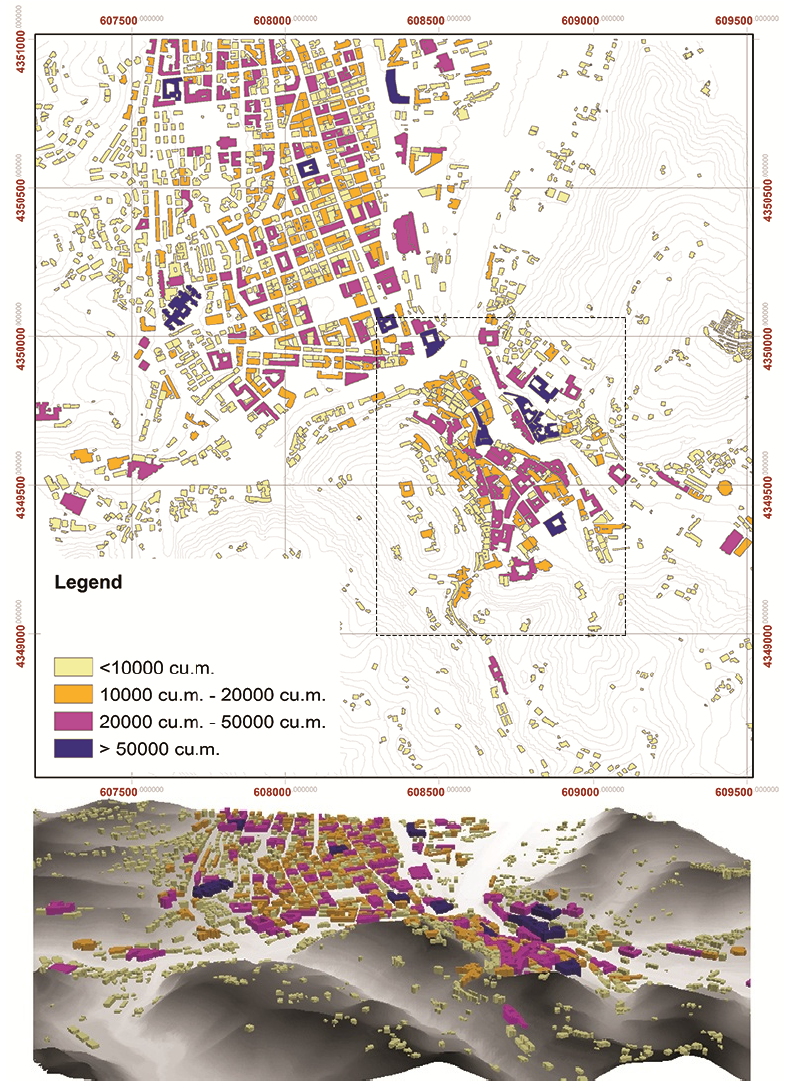
Figure 9. Classification of the buildings in the urban area of Cosenza based on the volumes’ (upper panel) 2D map, and (lower panel) 3D view